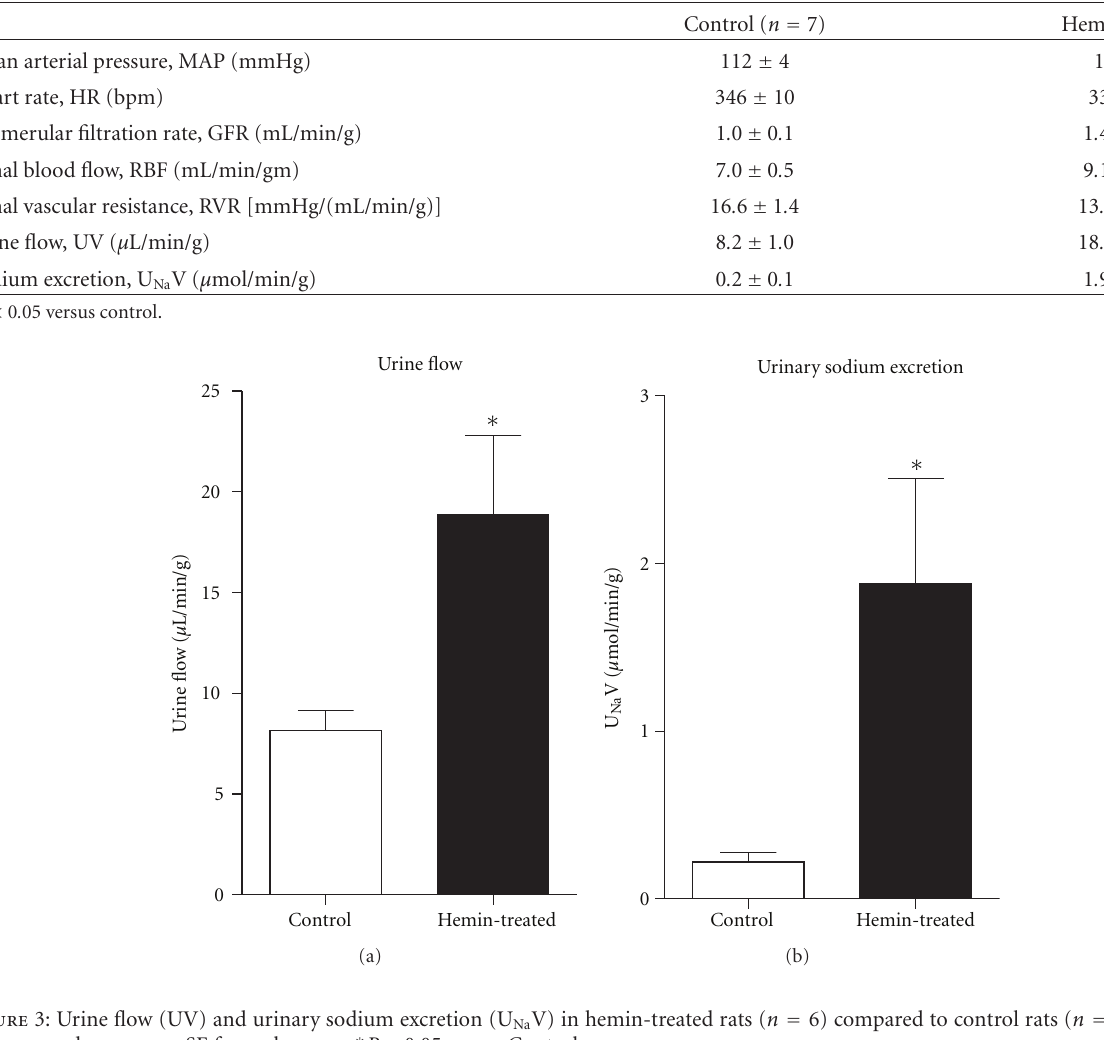
Table 1: Hemodynamics and renal excretory measurements in hemin-treated rats compared to control untreated rats.